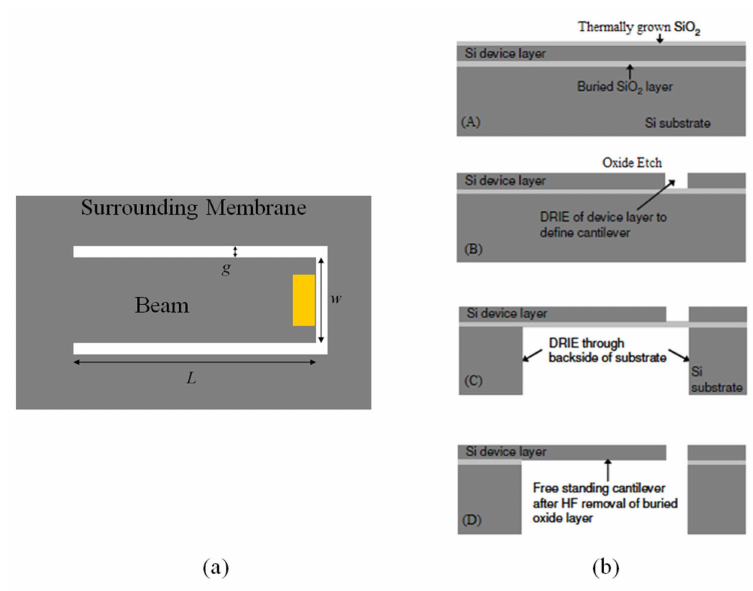
Figure 8. Cantilever sensor illustration showing: ( a ) a top view of the cantilever and the surround membrane area and ( b ) a cross sectional view of the individual fabrication steps where (A) is a wet thermal oxide grown at 1000 ˝ C; (B) the oxide is etched away and the cantilever is shaped using deep reactive ion etching (DRIE); (C) is the backside DRIE handle wafer etch up to the buried oxide and (D) is the final oxide release etch using a hydrofluoric acid vapor etch.